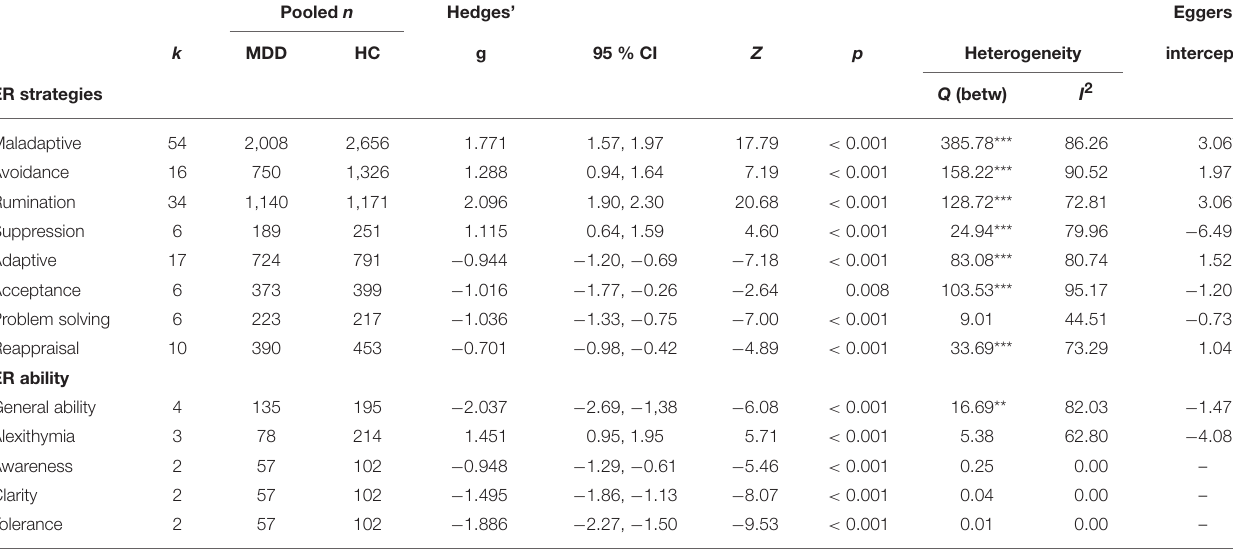
TABLE 1 | Synthesis of results from studies with participants diagnosed with current MDD. Pooled n Hedges’ Eggers